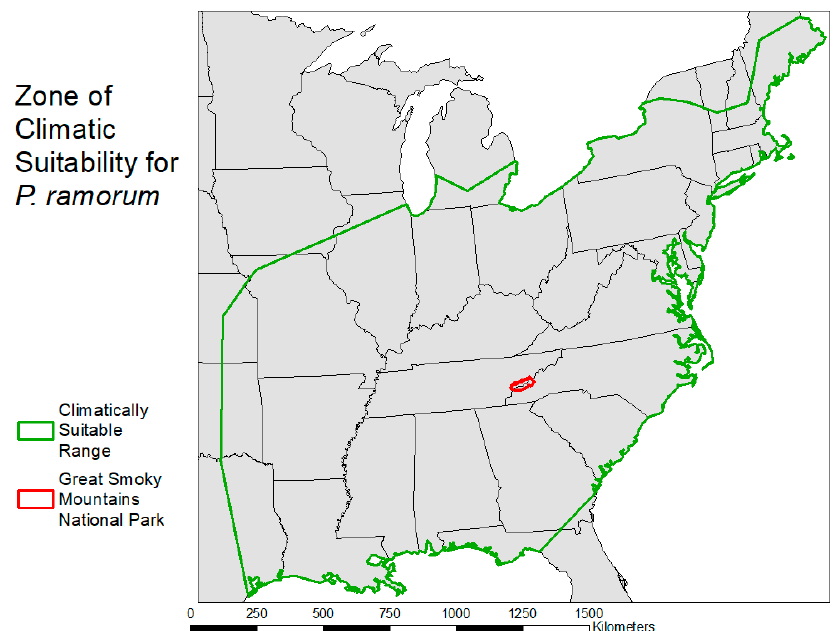
Figure 1. The green area represents the broad area of climatic suitability for P. ramorum in the eastern USA, combining the rough outlines of the suitable areas found by Ireland et al. [8] and Venette and Cohen [12]. The red area is the focal area used for the network analysis of P. ramorum spread.